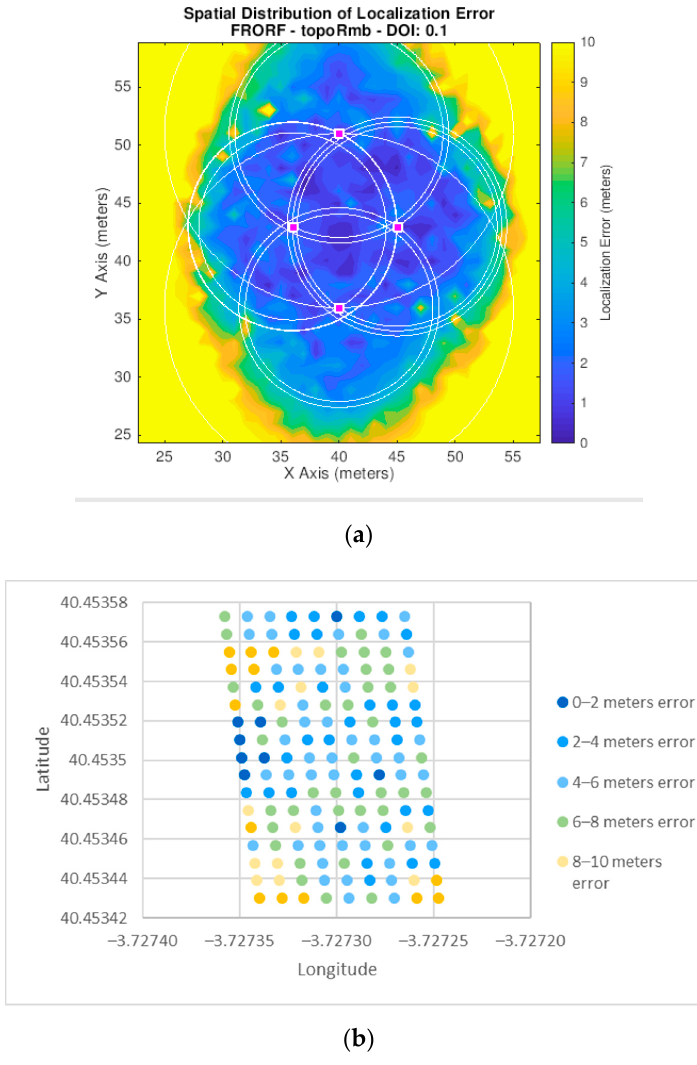
Figure 21. Experiments mean error results for scenario 3. ( a ) Scenario 3 in the simulator ( p -value = 0.5); ( b ) scenario 3 in the outdoor set-up ( p -value = 0.5).